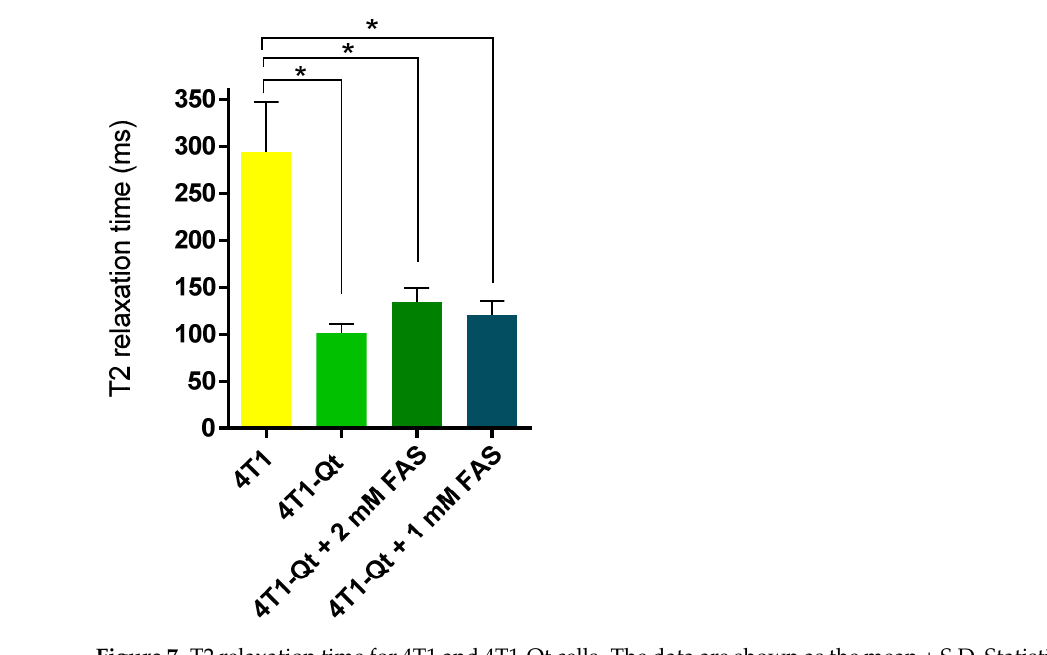
Figure 7. T2 relaxation time for 4T1 and 4T1-Qt cells. The data are shown as the mean + S.D. Statistical analysis was performed using an unpaired t -test (* corresponds to p -value < 0.05). The relaxation time of wild-type 4T1 cells after their incubation with FAS was not measured. It is known that, in cells dying by ferroptosis, the intensity of the MR signal may increase [14,15], and this experiment was deemed inappropriate in our case (cf. FAS toxicity data presented above).